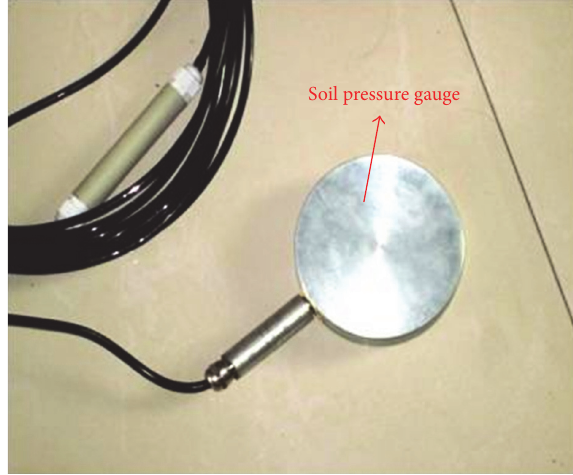
Figure 16: Soil pressure gauge.